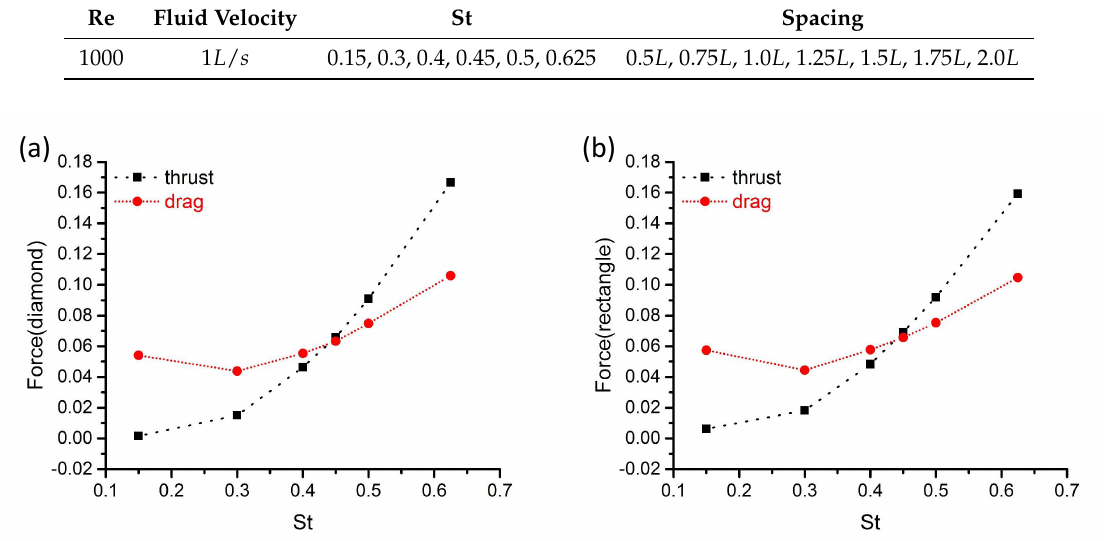
Figure 7. Results of the average force when the spacing is 1 L : ( a ) the diamond swarm, ( b ) the rectangle